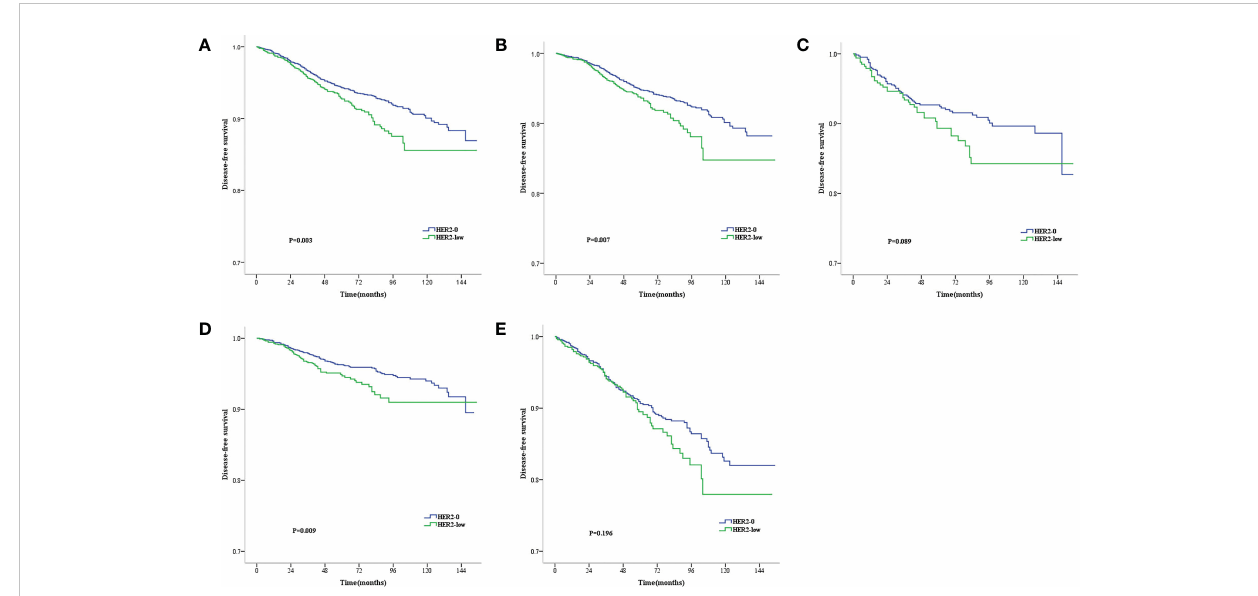
FIGURE 3 Kaplan – Meier survival curves for DFS strati fi ed by hormone receptor (HR) status and lymph node status.DFS for HER2-low vs. HER2-0 tumors in the complete cohort (A) , HR-positive population (B) , HR-negative population (C) , Lymph node-negative population (D) and lymph node-positive population (E) . p values are from the strati fi ed log-rank